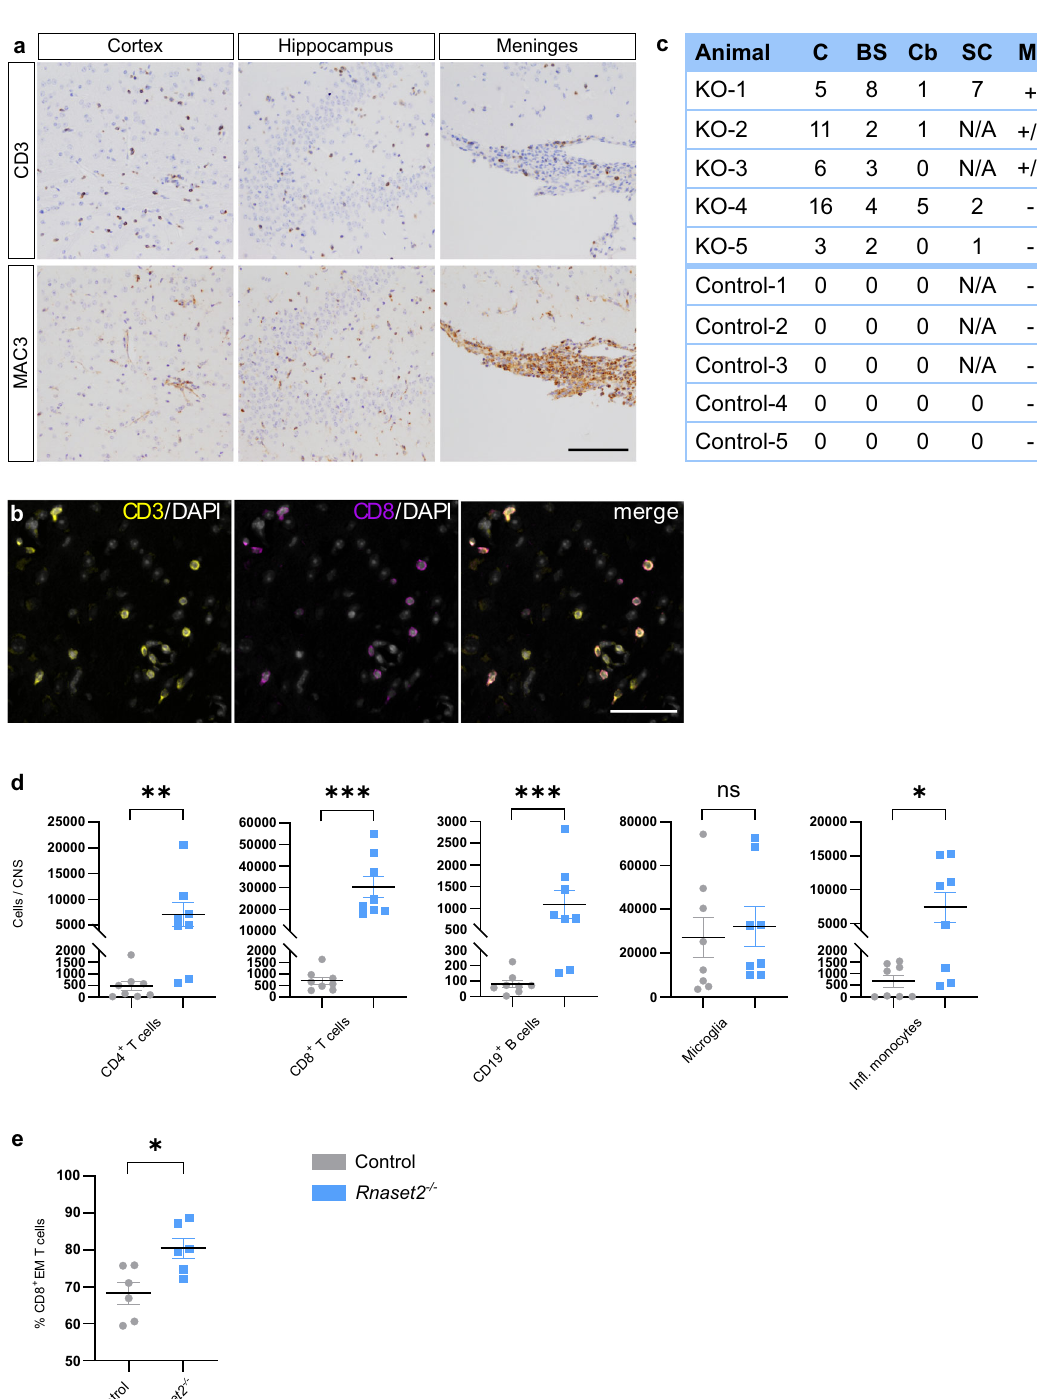
mitochondrial oxidative phosphorylation precedes